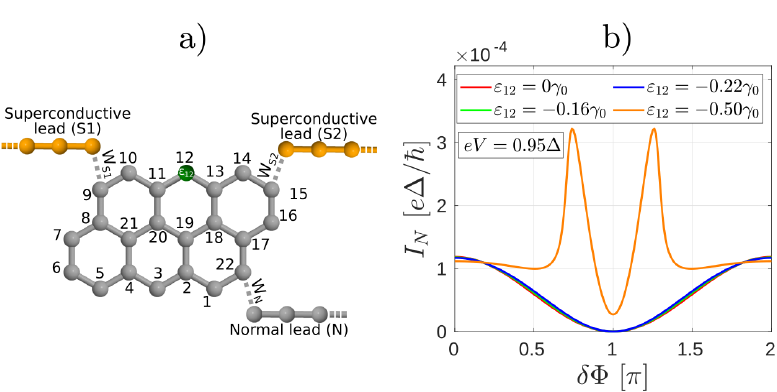
Figure 10. ( a ) Anthanthrene molecule with a heteroatom (denoted by green) and the same configuration of leads as in Figure 1. ( b ) The normal current I N as a function of the phase difference δ Φ between the superconducting leads for the setup in ( a